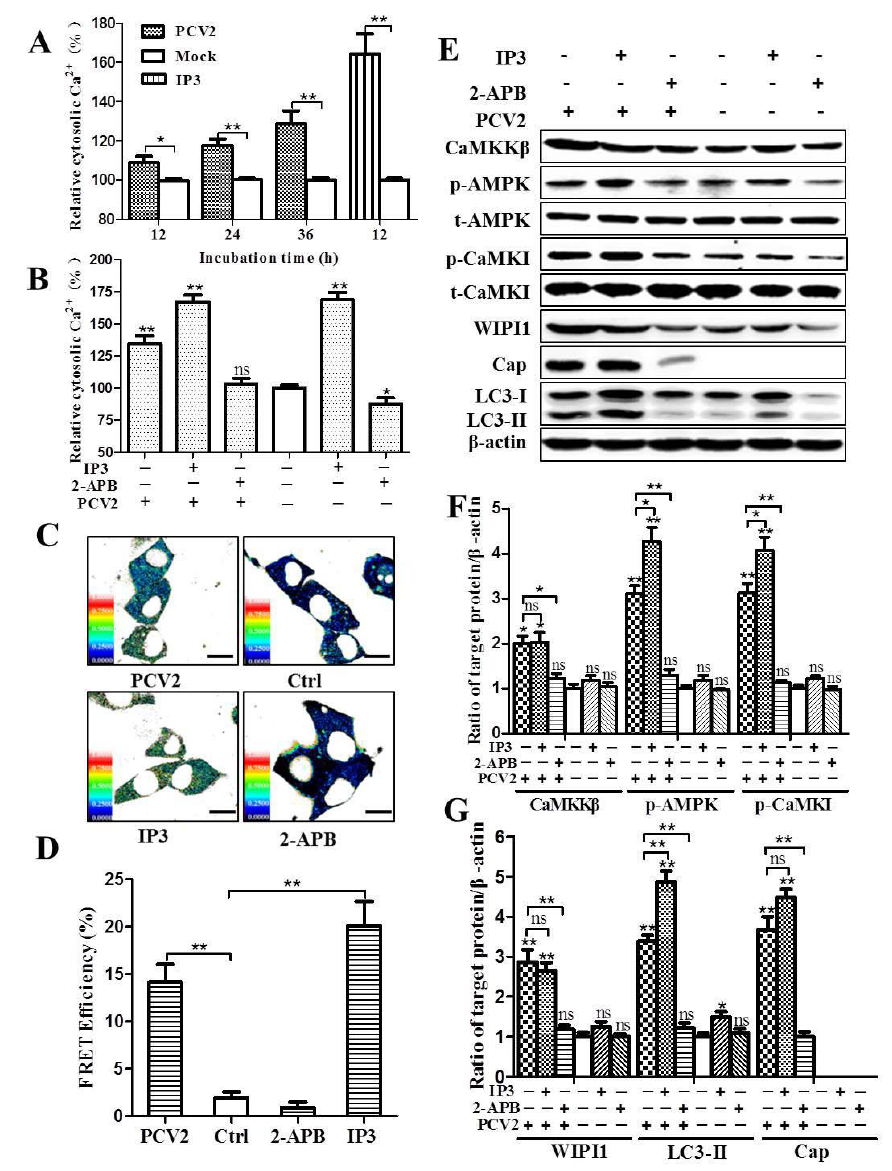
Figure 7. PCV2 increased cytosolic Ca 2+ likely from the endoplasmic reticulum (ER) via inositol 1,4,5-trisphosphate receptor (IP3R) to activate CaMKK β and its substrates. ( A , B ) PK-15 cells were infected with PCV2 (MOI « 1) for indicated time points or treated with 10 mM inositol 1,4,5-trisphosphate (IP3) or 100 µ M 2-APB at 12 hpi, and then incubated for additional 24 h before being subjected to cytosolic Ca 2+ measurement based on chemical Ca 2+ indicator Fluo 3-AM by flow cytometry. ( A ) Cytosolic Ca 2+ levels relative to mock at 12, 24 and 36 hpi. ( B ) Cytosolic Ca 2+ levels of PCV2-infected cells treated with IP3 or 2-APB at 36 hpi relative to mock-infected cells without IP3 and 2-APB treatments. ( C , D ) Genetically encoded Ca 2+ indicator TN-XXL expressing plasmid (pcDNA3-TN-XXL) was transiently transfected into PK-15 cells pre-infected with PCV2 at 6 hpi (MOI « 1). Mock-infected cells (Ctrl) or cells treated with IP3 (10 mM) or 2-APB (100 µ M) were included for comparative purposes). ( C ) Cells were subjected to cytosolic Ca 2+ measurement based on fluorescence resonance energy transfer (FRET) under the confocal microscope (scale bar, 10 µ m) at 36 hpi. ( D ) Average FRET efficiency from at least 50 cells/experiment in three independent experiments as represented in the panel D. ( E ) The whole cell lysates with different treatments collected at 36 hpi were also subjected to Western blotting for CaMKK β , p-AMPK and p-CaMKI, t-AMPK, t-CaMKI, WIPI1, Cap and LC3-II. ( F , G ) Ratios of target molecules to β -actin were normalized to mock infection without IP3 and 2-APB treatments, and set at 1.0. Data are reported as the mean ˘ SEM of three independent experiments (ns, p > 0.05; * p < 0.05; and ** p <